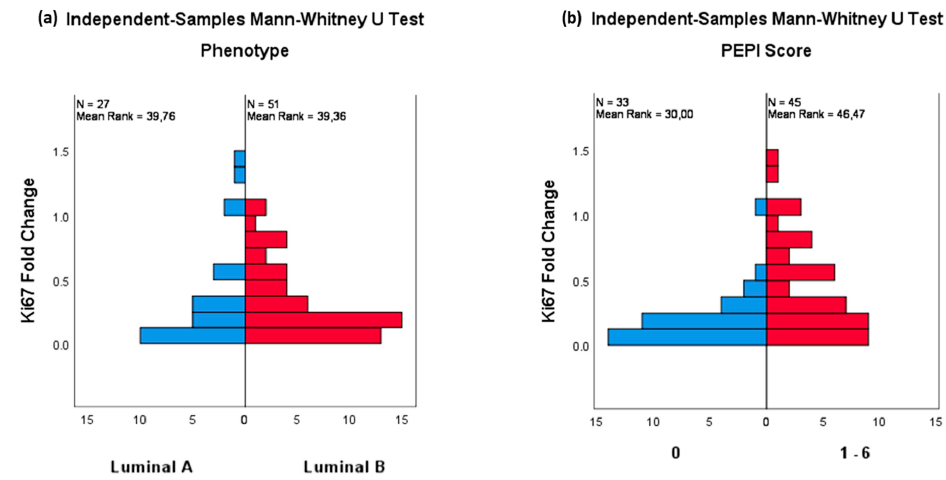
Figure 3. ( a ) Phenotype and 4wk-Ki67 fold change. ( b ) PEPI score and 4wk-Ki67 fold